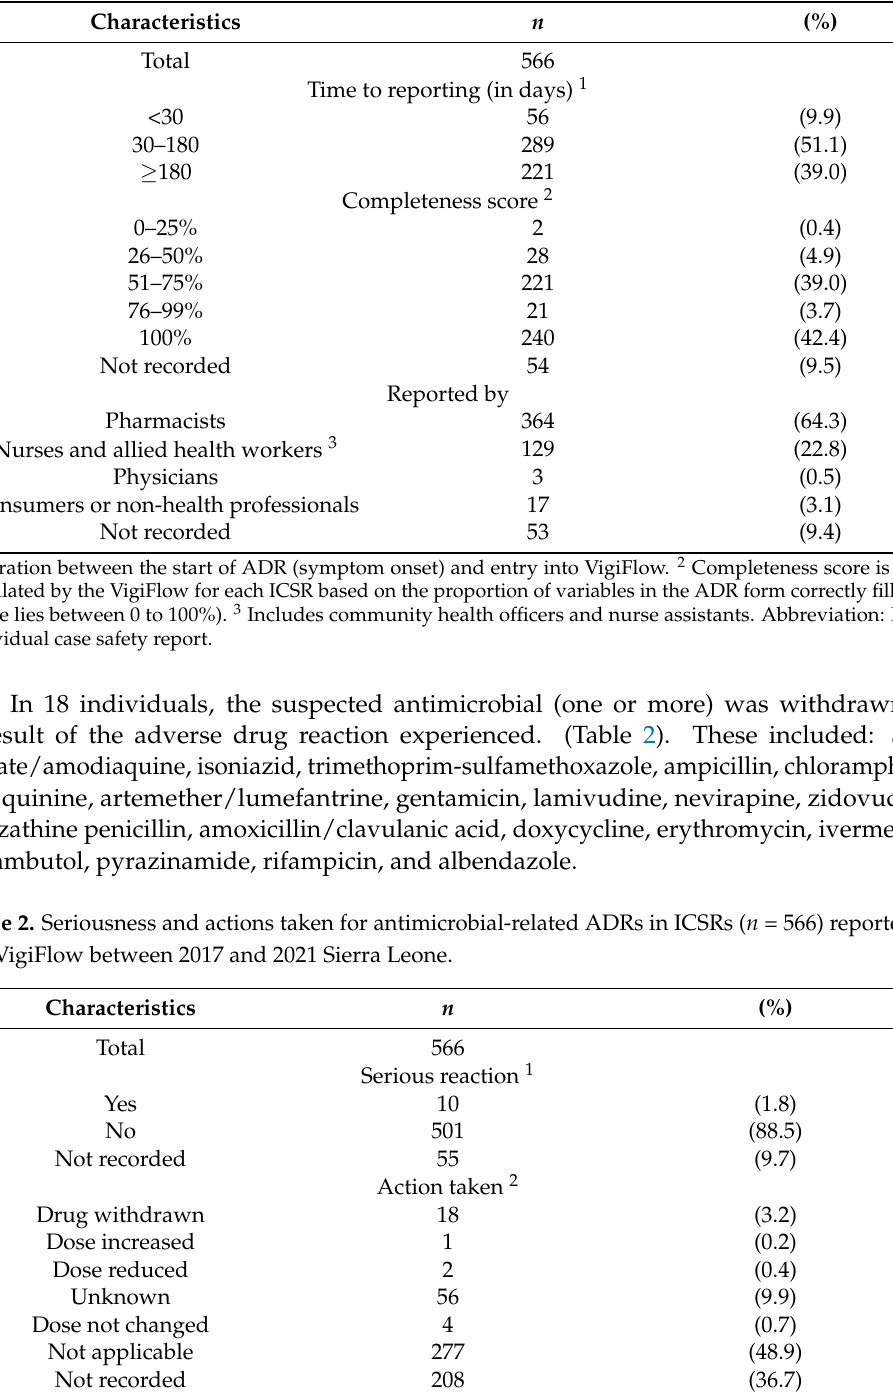
Table 1. Timeliness and completeness of ICSR reporting ( n = 566) in the VigiFlow in Sierra Leone during 2017–2021.